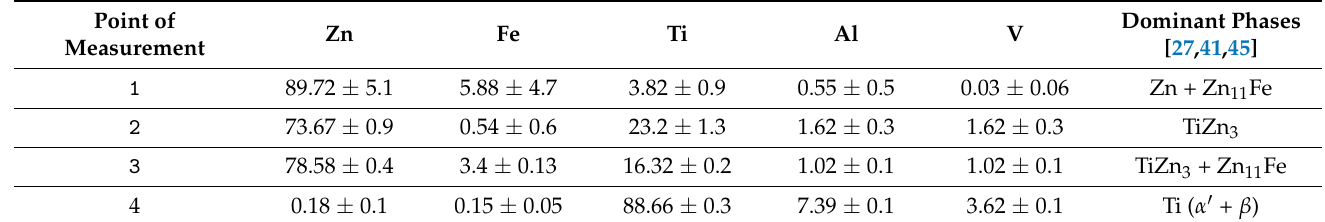
Figure 2. Microstructure of hybrid Ti-Zn system by SEM ( a ) points of EDS measurements ( b ) Close- up view at the interface between Ti-based lattice and Zn-based alloy. Table 1. Spot chemical compositions (at%) by EDS at points shown in Figure 2a. Table 1. Spot chemical compositions (at%) by EDS at points shown in Figure 2a.